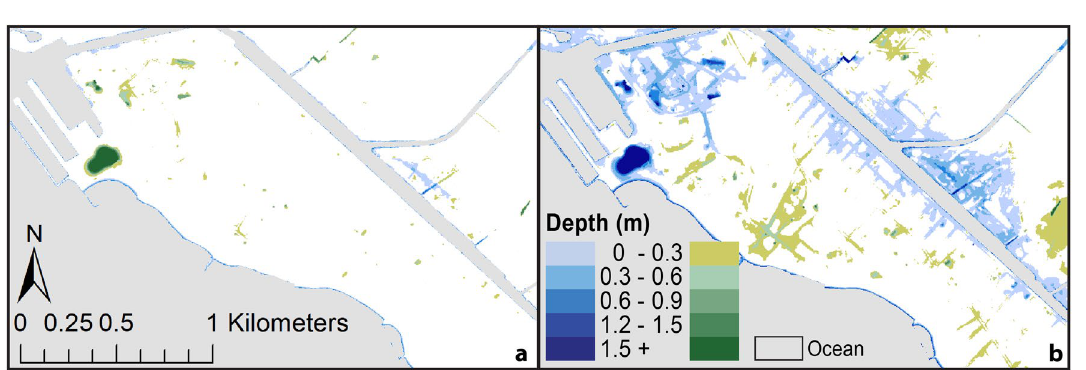
Figure 6. Maps depicting flood depth ranges with at least 80% probability in Waikīkī, ( a ) RSLR flooding scenario by 2050 (High scenario, 0.75 m); ( b ) RSLR flooding scenario by 2100 (Intermediate scenario, 1.19 m) as projected using ORS method (blues—surficially connected; greens—topographically isolated). (Maps generated with ArcGIS Desktop 10.8.2; http:// www. esri. com).